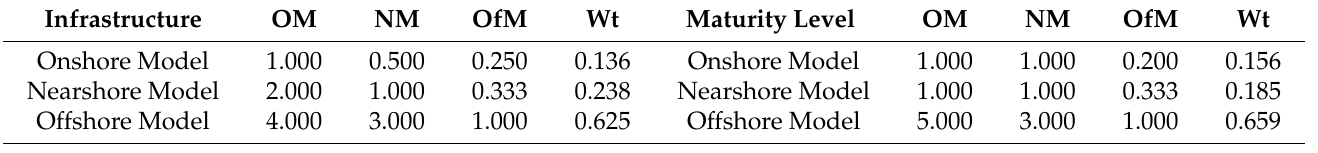
Table A4. Case study-2: Calculation of alternative preferences with respect to infrastructure and maturity level. Infrastructure